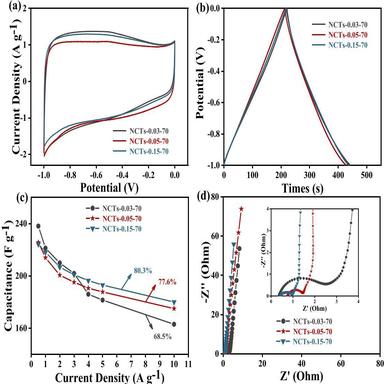
Electrochemical performance of NCTs-0.03/− 0.05/− 0.15–70. (a) CV curves at the scan rate of 5 mV s −1, (b) GCD curves at current density of 1 A g−1, (c) Specific capacitance from 0.5 to 10 A g−1, (d) EIS of all samples and inset is the enlarge.